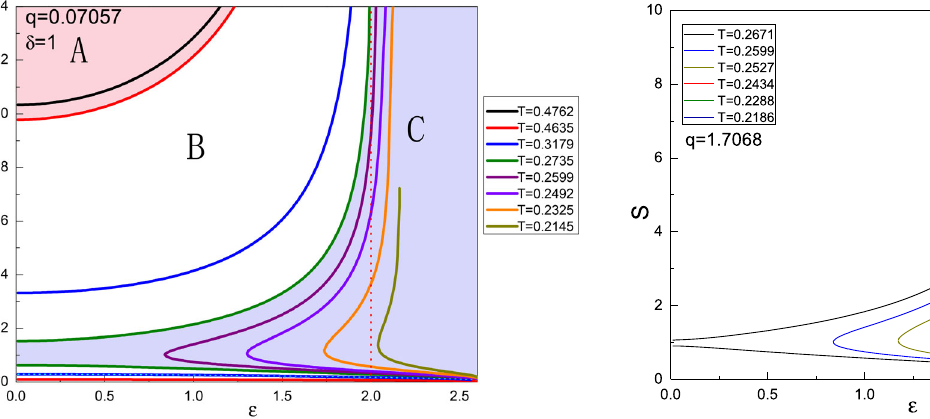
Fig. 7 The entropy as functions of boundary rotation parameter ε for different values of temperature T with δ = 1. Left: for q = 0 . 07057, local maximum and minimum of temperature T are equal to 0 . 4635 and 0 . 2735 represented by red and green lines respectively. The two